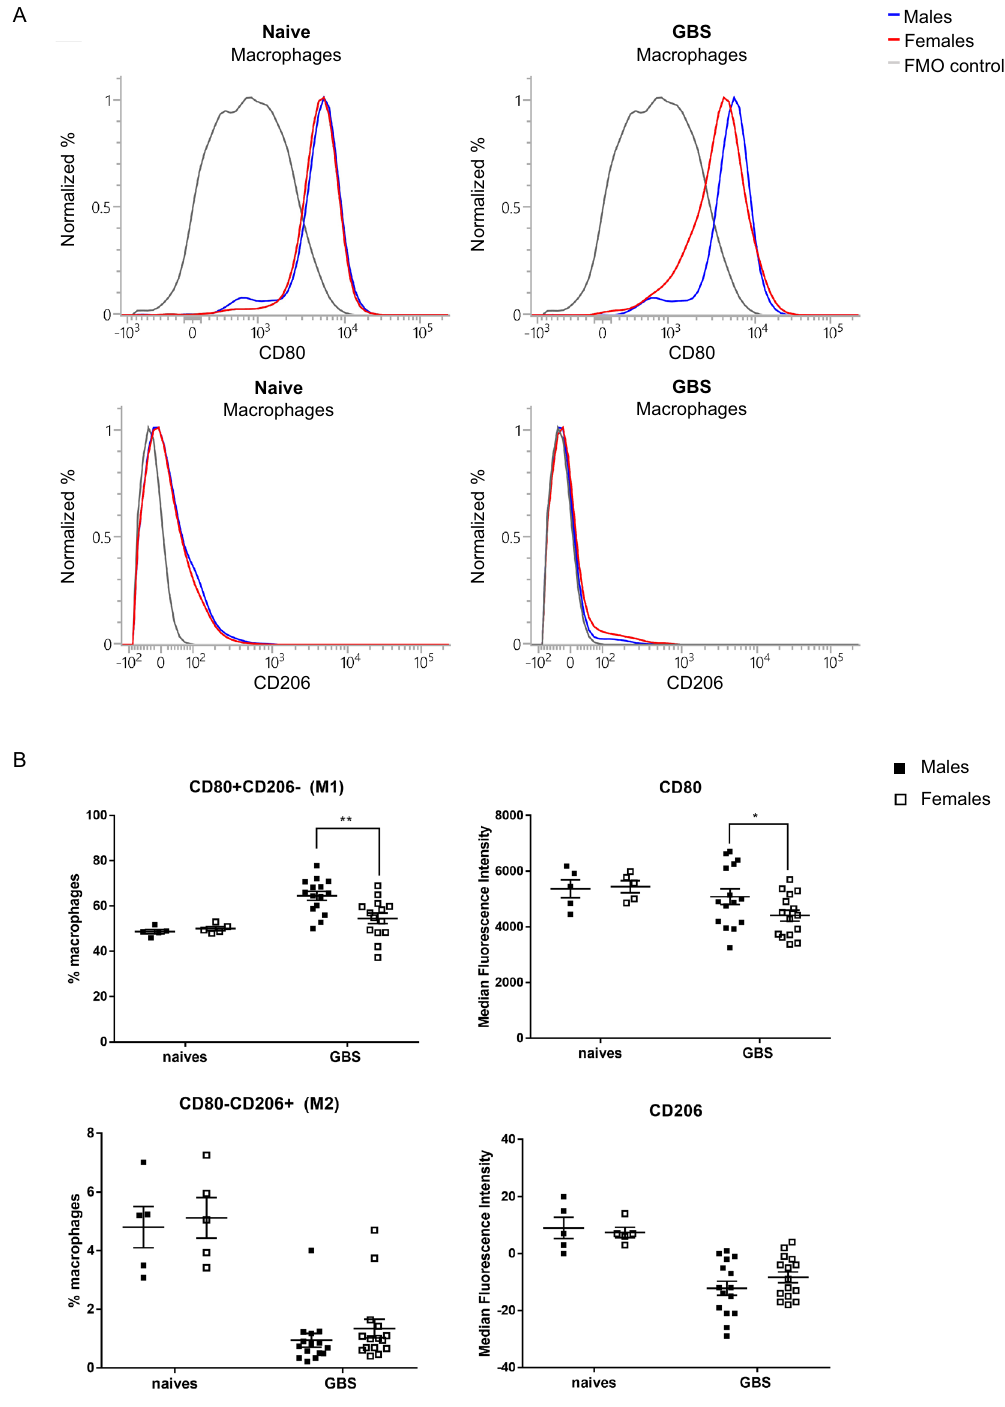
Figure 5. Sex-based analysis of M1 and M2 polarization markers on macrophages at 24 h post GBS lung infection. Male (black) and female (white) C57BL/6 mice were infected intranasally with ± 10 8 CFU of GBS (n = 15/group). Naive mice were used as controls (n = 5/group). ( A ) Expression levels of CD80 (M1) and CD206 (M2) were compared by flow cytometry on macrophages (CD45+, CD64+, MHCII+) shown in histograms: blue line represent the fluorescent profile of males; red lines represent the fluorescent profile of females and grey lines represent the fluorescent profile for Fluorescence Minus One (FMO) control. ( B ) The % of macrophages positive for surface marker CD80 and negative for CD206 (M1) as well as the % of macrophages positive for surface marker CD206 and negative for CD80 (M2) were determined. Evaluation of the mean fluorescence intensity (MFI) for CD80 and CD206 surface marker expression was also analyzed at the macrophage level. *p < 0.05, **p < 0.01 (Mann–Whitney U test). Data are representative of three independent